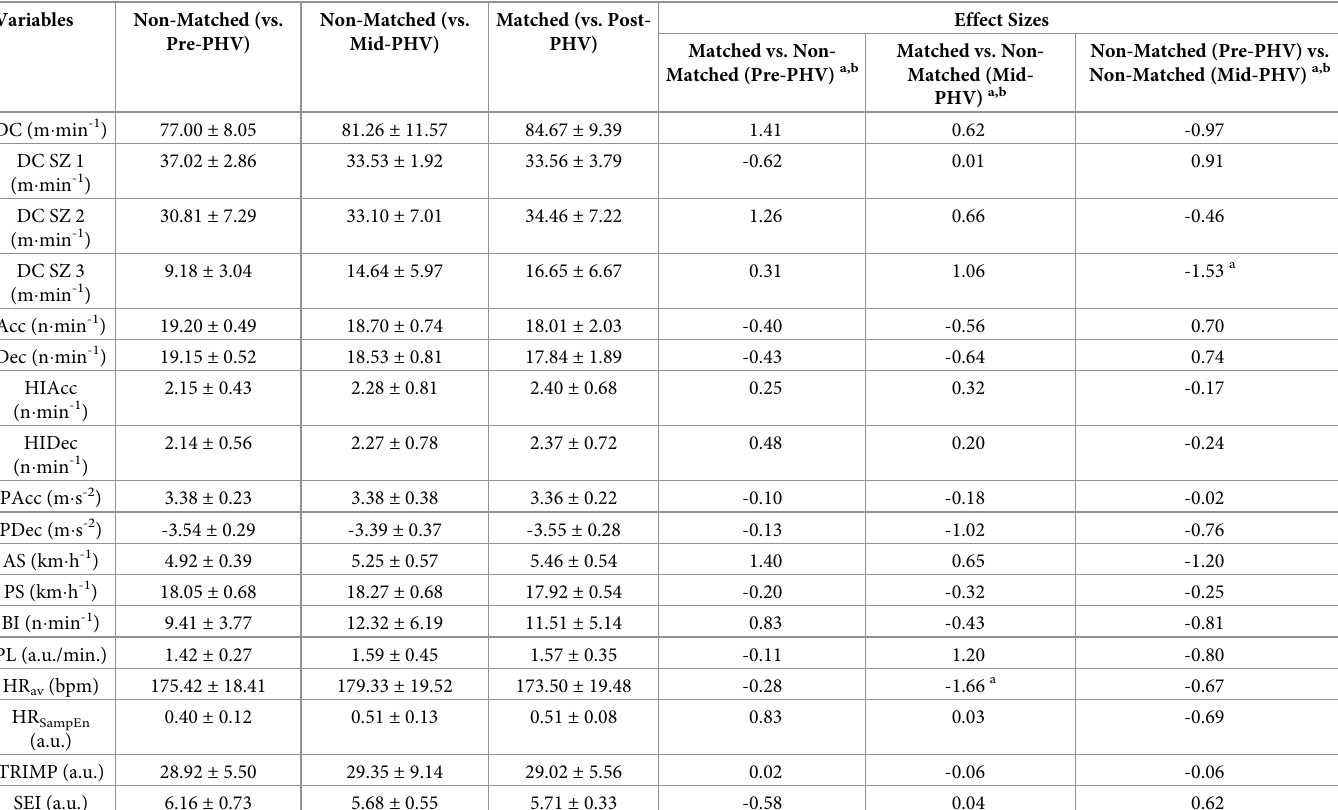
Table 4. Mean ( ± SD) physical and tactical performance produced by Post-PHV during game formats.